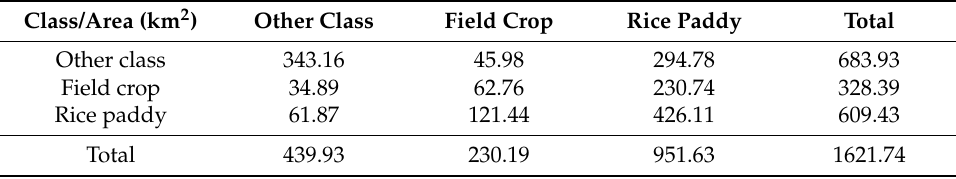
Table 9. Confusion matrix of the original dynamic time warping (ODTW) method in test site 1.